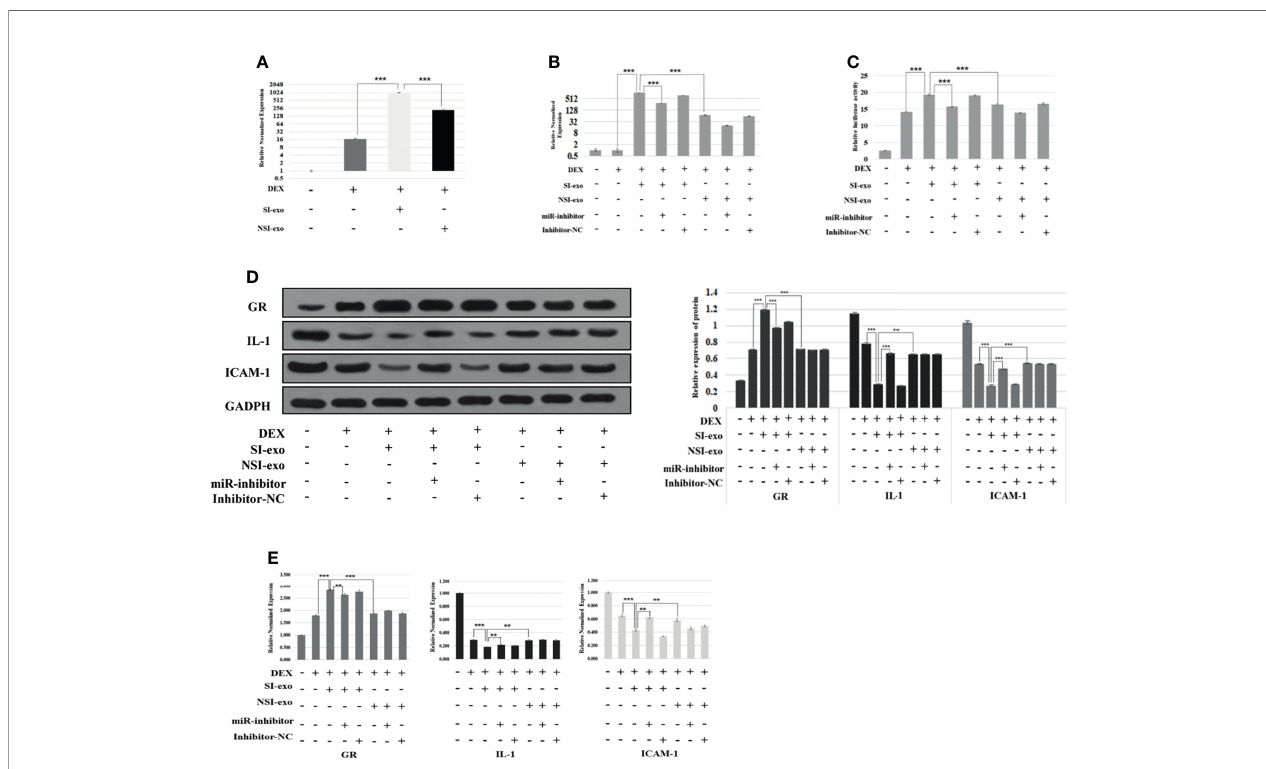
FIGURE 3 | SI-exo improves the glucocorticoid sensitivity of OFs by transmitting mir-885-3p. (A, B) Statistical chart of PCR detection of mir-885-3p in each group. DEX: 0.1 m m DEX-treated OFs for 24 h; SI-exo/NSI-exo: 25 m g/ml SI-exo/NSI-exo-treated OFs for 24 h; miR-885-3p: miR-885-mic-treated OFs for 24 h; miR-nc: NC miRNA- treated OFs for 24 h; ** p < 0.01; *** p < 0.001. (C) Plasmid activity of GRE luciferase reporter gene results in each group; grouping and statistical methods are the same as in (B) ; (D) Western blot detection of GR, IL-1, and ICAM-1 protein levels in each group; grouping and statistical methods are the same as in (B) . (E) Statistical chart of PCR detection of GR, IL-1, and ICAM-1 mRNA levels in each group; grouping and statistical methods are the same as in (B)